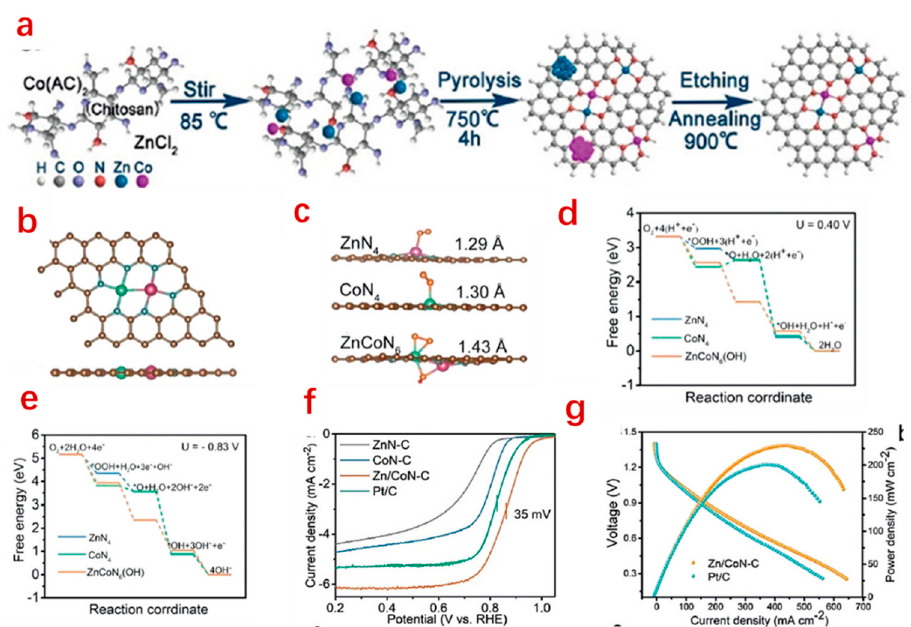
Figure 7. Schematic illustration of the synthesis process of Zn/CoN–C ( a ); the proposed structure of Zn/CoN–C ( b ); O–O bond length after adsorption on the various system ( c ); (brown, blue, yellow, green, purple, and red balls are C, N, O, Zn, Co, and H atoms, respectively) free energy diagrams ( d , e ); ORR activity in an alkaline electrolyte ( f ); and zinc–air batteries performance ( g ) [74].